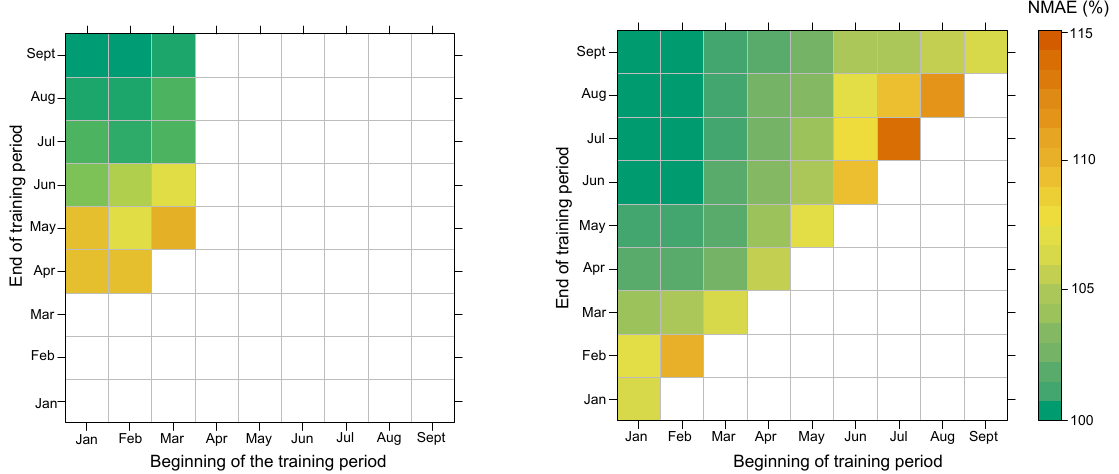
Figure 10. Forecasting performance depending on the exact period of the training set, i.e., the beginning of the training period ( x -axis), and its end ( y -end). For each training period, the relative NMAE is equal to the average NMAE over the Ξ subset divided by the minimal NMAE obtained with the maximal training period. The left panel represents the results obtained with M 2 , the right panel represents the results with G 2 .